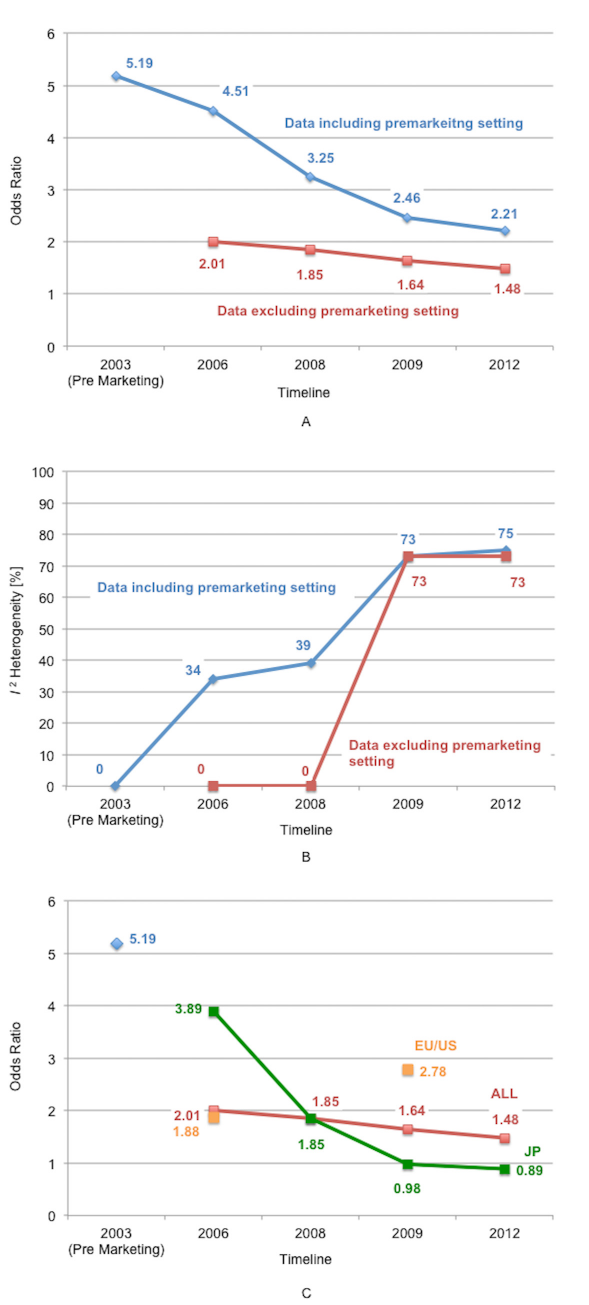
Fig 4. Changes in odds ratio and heterogeneity according to the time series. A: Odds ratio: Comparison between including and excluding premarketing data. B: Heterogeneity. C: Odds ratio: Subgroup analyses of the regional difference of